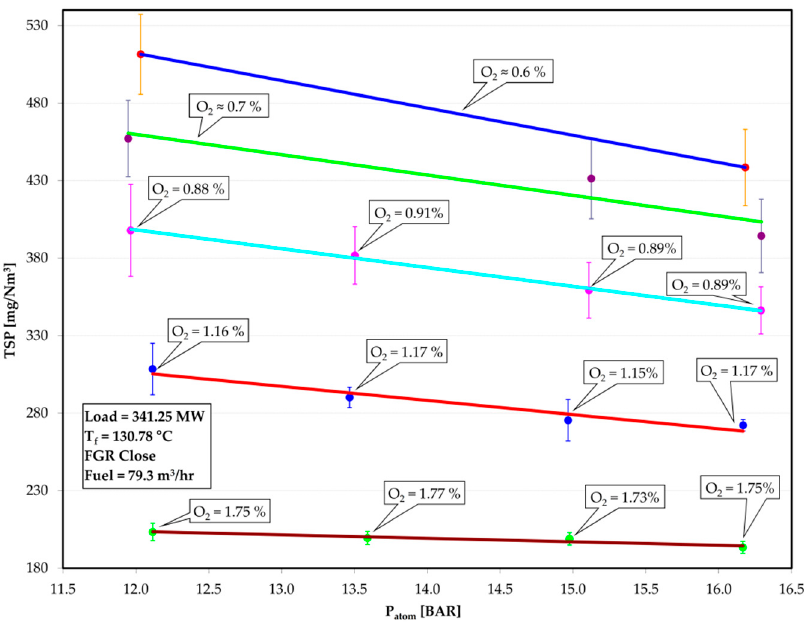
Figure 4. Steam atomization pressure effects on TSP emissions.